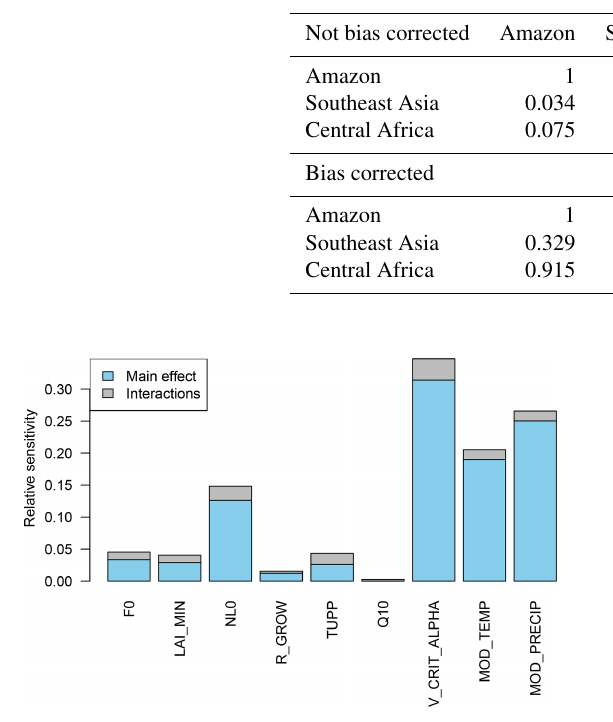
Table 4. Proportion of shared NROY input space for each forest pair compared to the total NROY space covered by the same forest pair. Not bias corrected (top) and bias corrected (bottom).